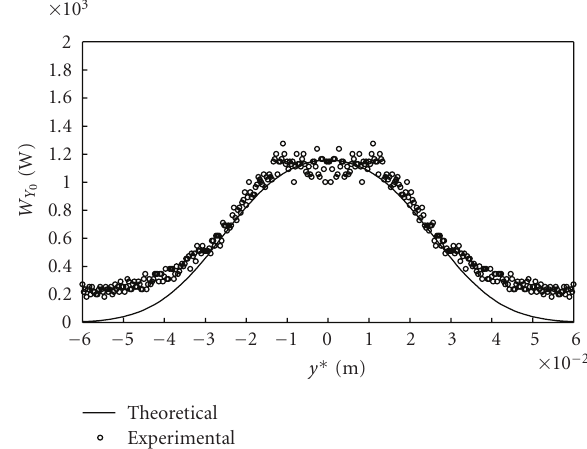
Figure 15: Heat flux distribution with a triangular magnetic field. Y 0 is assumed as 2 . 2 × 10 − 2 m.